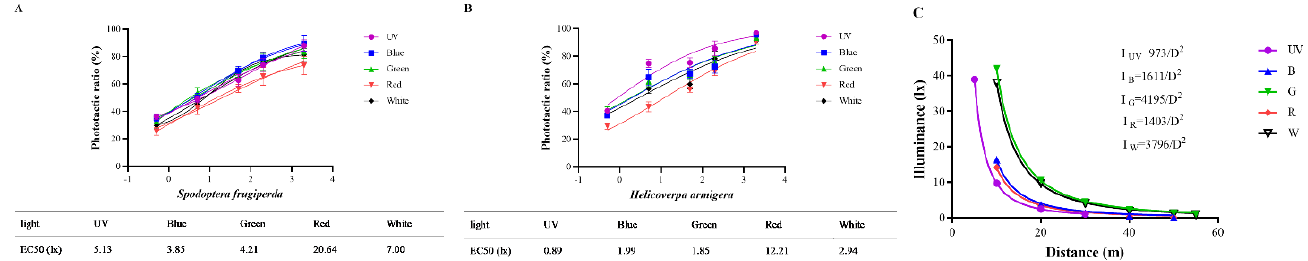
Figure 6. EC50 of S. frugiperda and H. armigera to different wavelength light sources. The fitting equation was obtained using the software of GraphPad Prism version: 9.3.0, and light intensities were converted by log. EC50 and was calculated by nonlinear regression curve fit and log (agonist) vs. normalized response − variable slope. ( A ) for S. frugiperda . ( B ) for H. armigera . ( C ) Light intensities of five light sources at different distances were measured and the relationship functions between light intensity and distance of each light source were calculated.